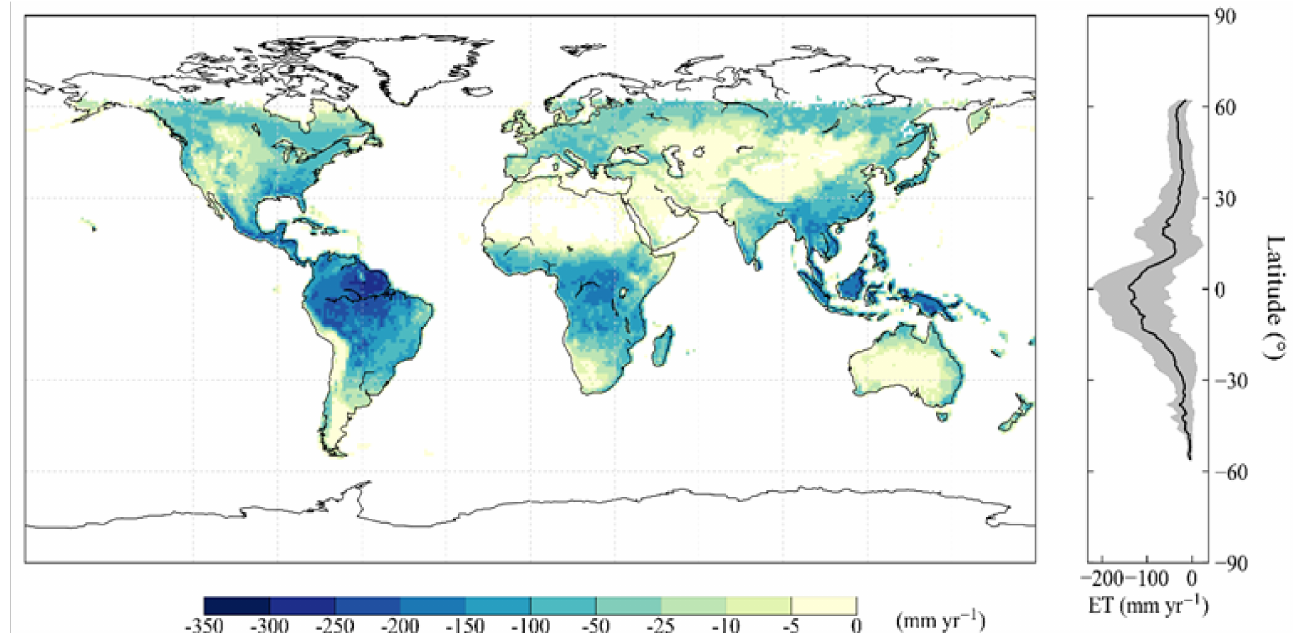
Figure 7. The spatial distribution of bias errors in global terrestrial ET estimates for Case